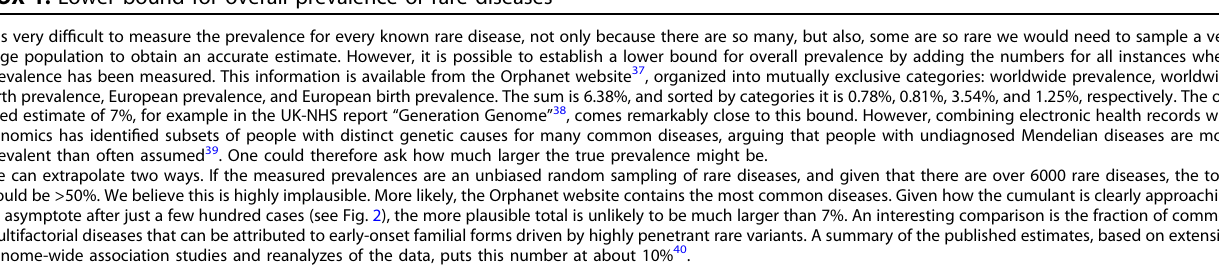
BOX 1: Lower bound for overall prevalence of rare diseases